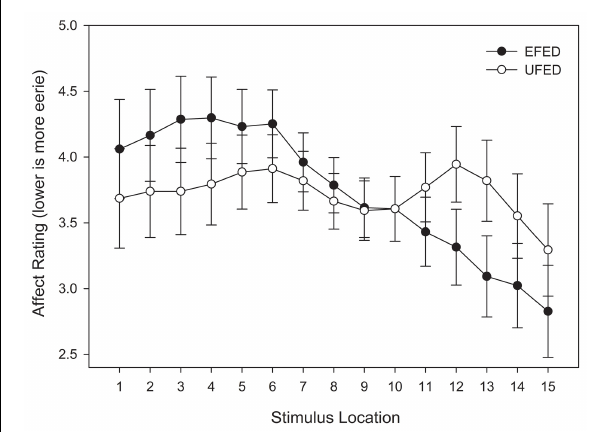
FIGURE 9 | Test affective responses (lower is more eerie) in equal frequency (EFED) and unequal frequency conditions (UFED). Stimulus values correspond to stimuli selected from the entire stimulus range (i.e., stimuli 1–15). Error bars represent 1 standard error of the mean ( N = 60).